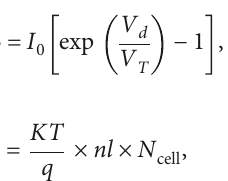
Figure 6: HOMER-optimized hybrid power system con fi guration.